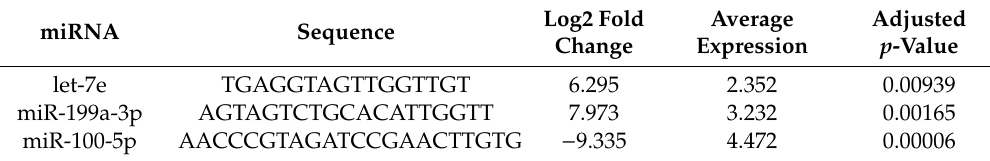
Table 2. Di ff erentially expressed isomiRs between kisspeptin and control in Senegalese sole females. Canonical mature miRNA names (from miRBase 21.0) are indicated, along with the sequence of the di ff erentially expressed miRNAs, their log2 fold change of the kisspeptin–control statistical comparison (corresponding to the log2 of the miRNAs’ average expression in Kisspeptin subtracting the average expression in control values computed by limma) and the isomiRs average log2 cpm in the dataset, as computed by limma. Benjamin–Hochberg adjusted p -values are also indicated. Log2 Fold Average Adjusted miRNA Sequence p -Value Change Expression let-7e TGAGGTAGTTGGTTGT 6.295 2.352